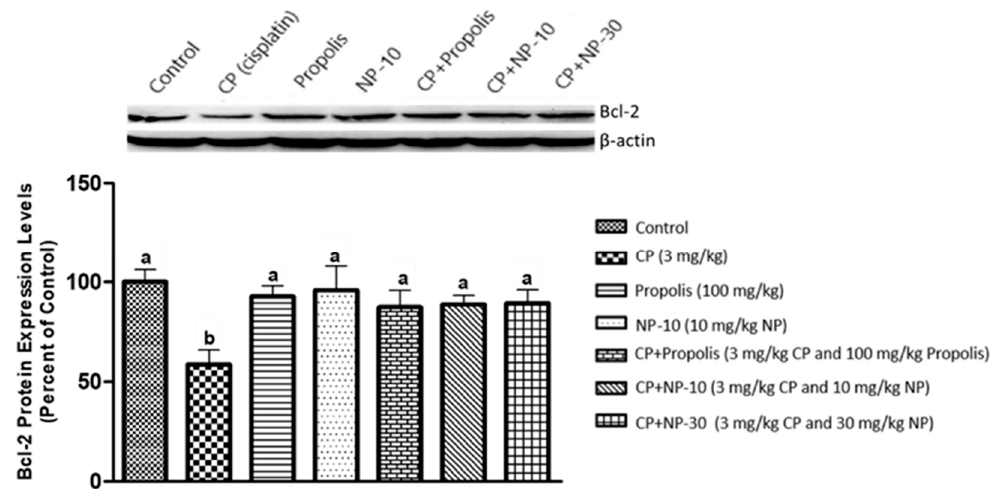
Figure 2. Bcl-2 protein expression levels in liver tissue. a,b,c: Mean values within a row differ significantly, Significance is p < 0.001 (NP: nano-propolis).